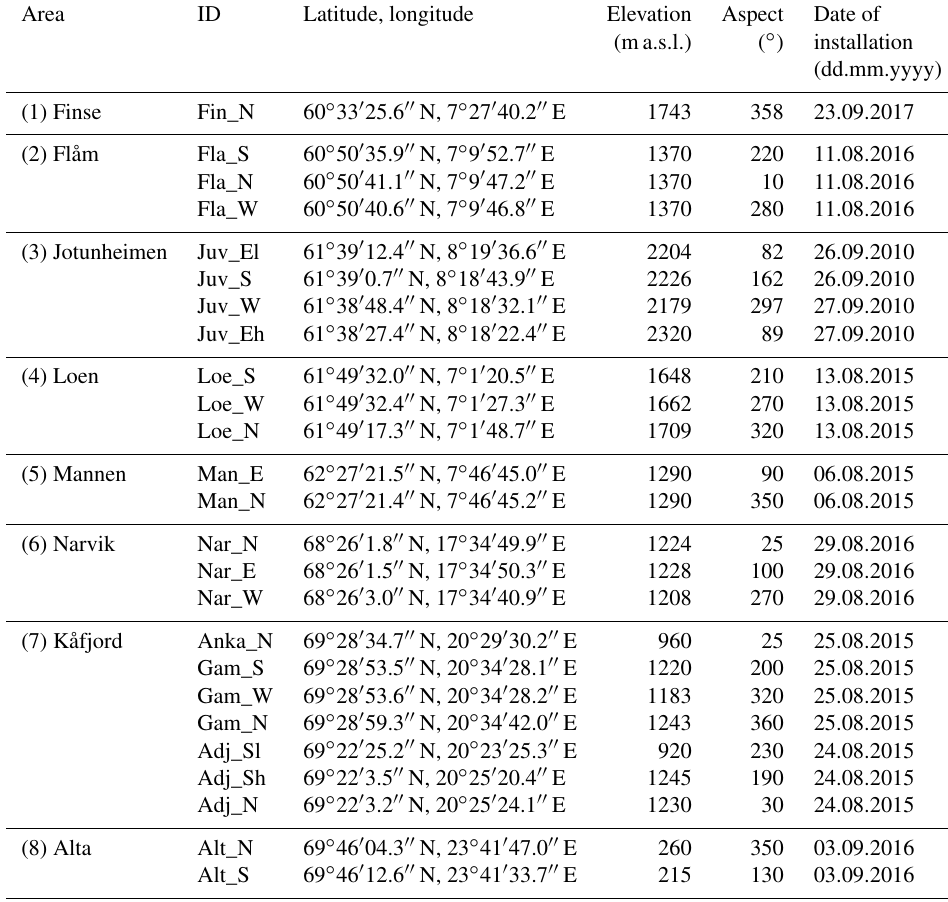
Table 1. Settings of the temperature sensors used in this study. Area ID Latitude, longitude Elevation Aspect